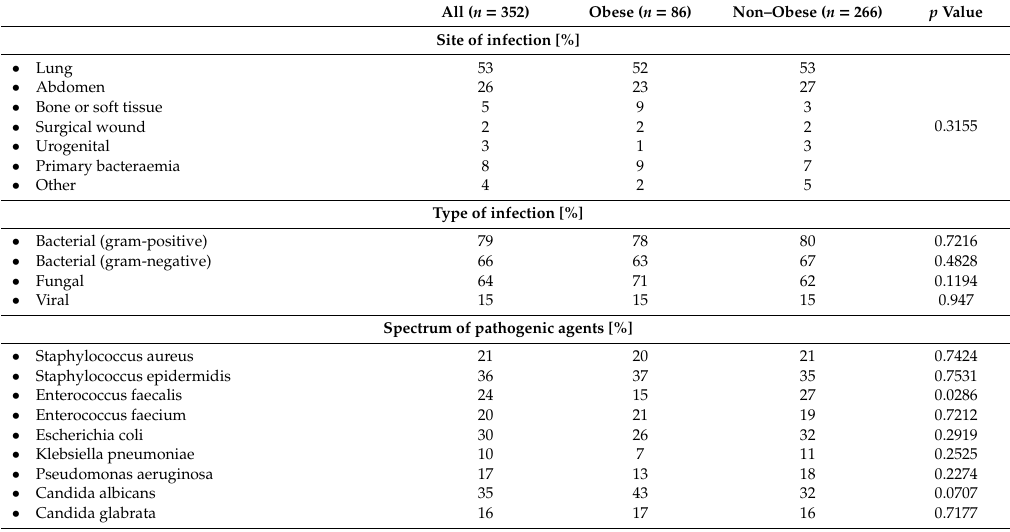
Table 3. Microbiological findings with respect to obesity